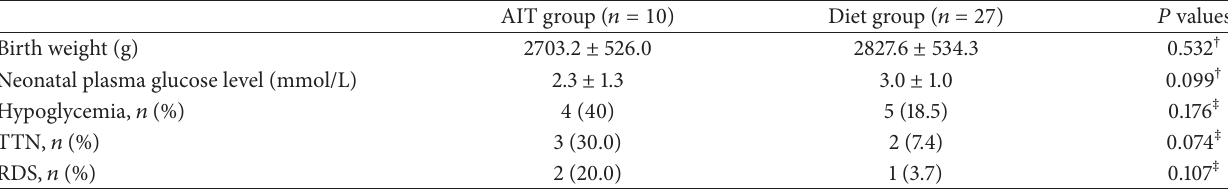
Table 6: Neonatal